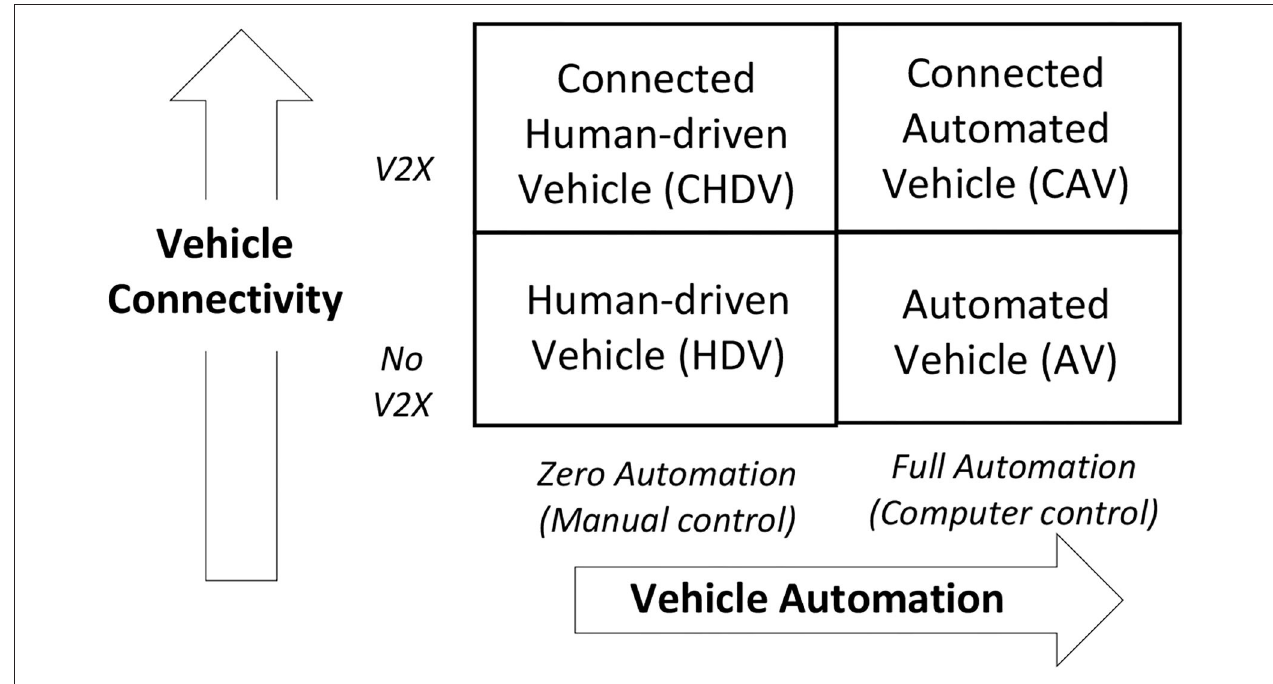
FIGURE 1 | The Automation-Connectivity Matrix.